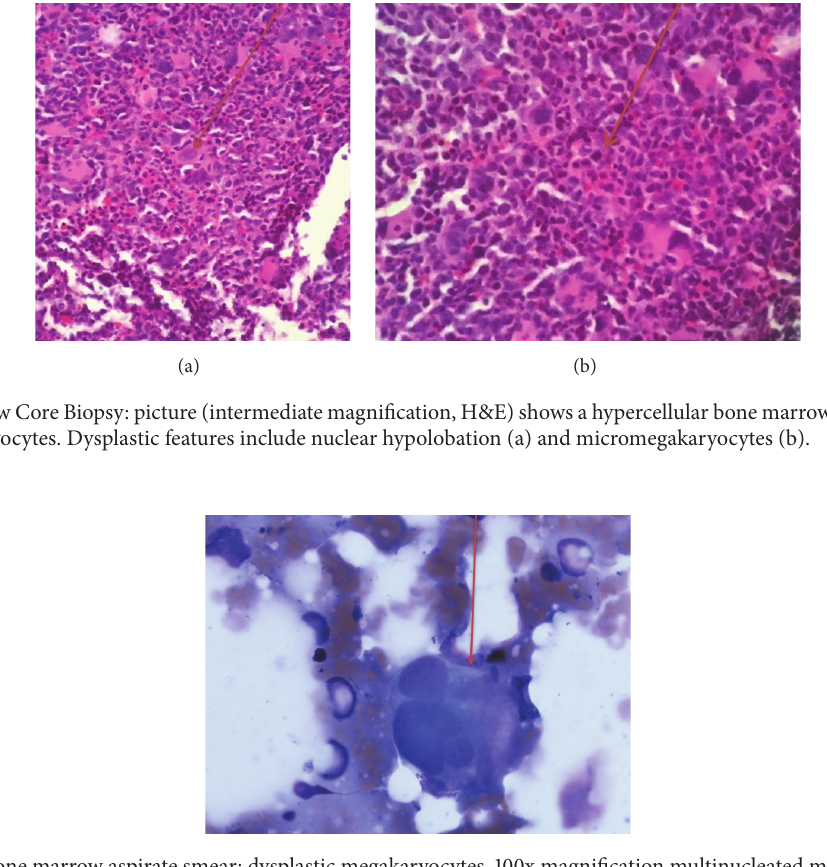
Figure 5: Bone marrow aspirate smear: dysplastic megakaryocytes, 100x magnification multinucleated